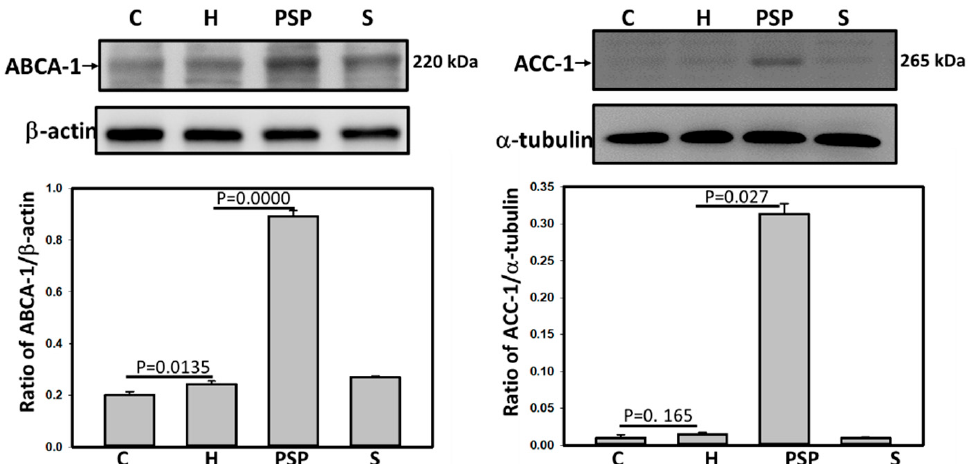
Figure 7. PSP treatment increased ABCA1 and ACC-1 levels. Immunoblot examination was per- formed to detect ABCA1 and ACC-1 levels. The β -actin or α -tubulin was used as the loading control. The relative image density was quantified by the densitometer. Ratio values calculated from triplicate experiments were represented as the mean ± SD shown in lower panel.